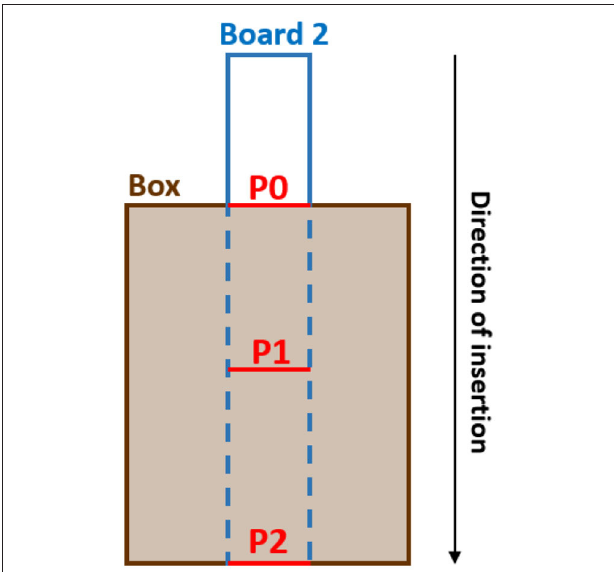
FIGURE 4 | How the time interval was defined in order to calculate AAO measure: P0 represents the point at which participants insert the second board (board 2) into one slot of the box, P1 represents the point where they insert it into the corresponding slot of the first board while inside the box, and P2 represents the point where they complete the